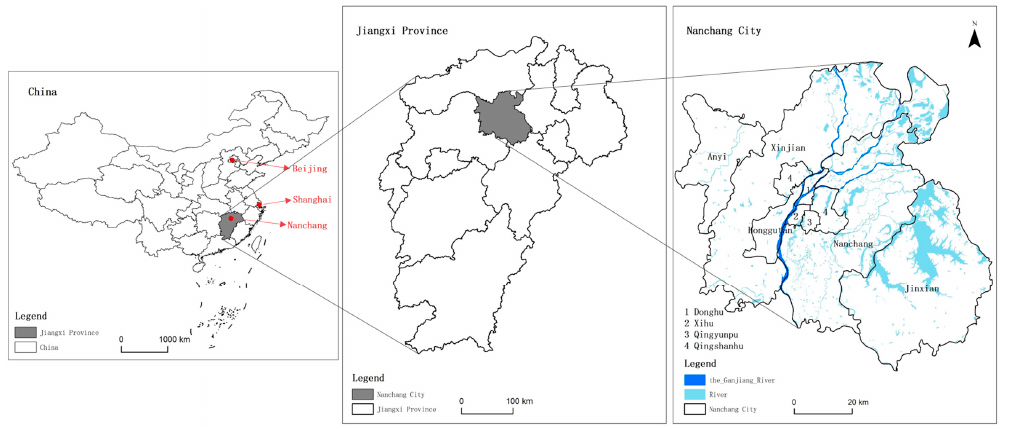
Figure 1. Study area.